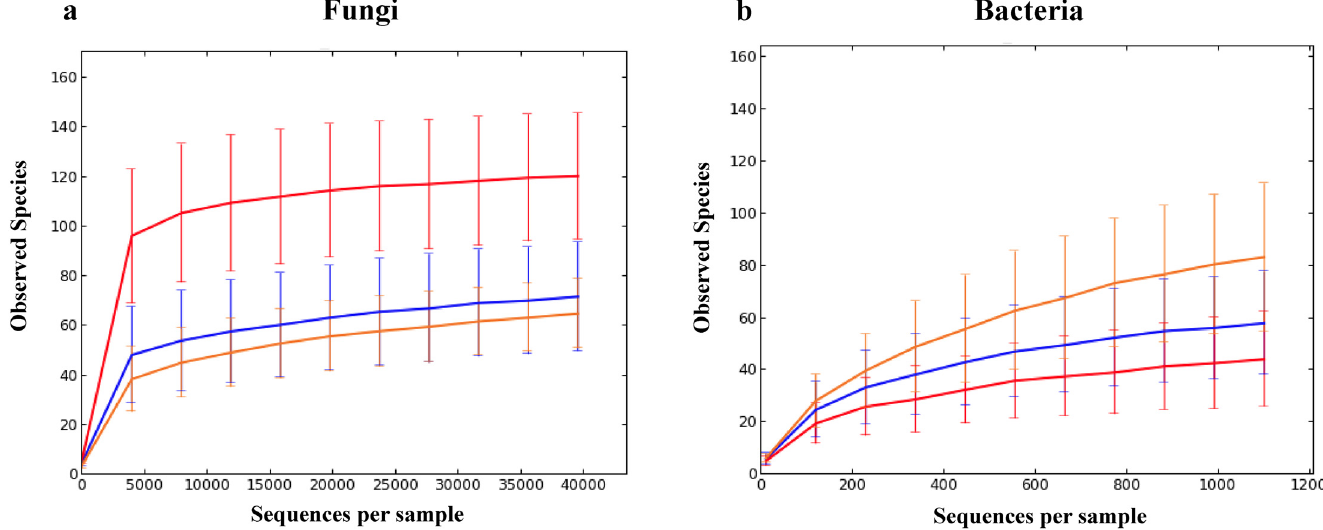
Fig 2. Rarefaction-based comparison of fresh tea leaf (red), raw (blue) and ripened (orange) Pu-erh samples with regard to fungal (a) and bacterial (b) richness. Fungi were rarefied at 39 507 sequences to keep all samples, while bacteria at 1103 sequences to exclude three fresh leaf samples (LN2, LS2, and LS4) and three raw Pu-erh samples (A3, A14, and